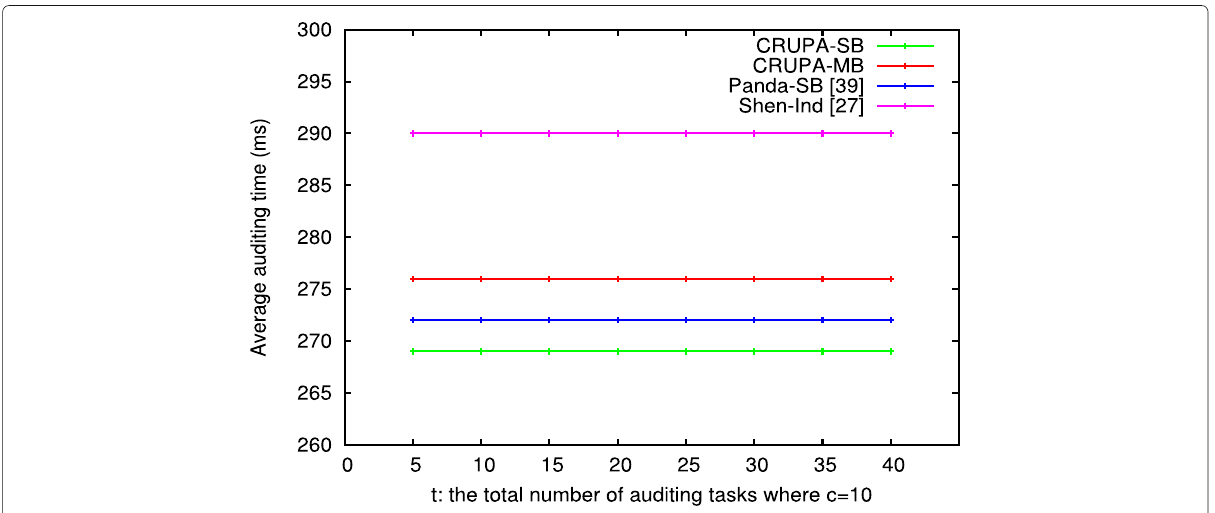
Fig. 6 Impact of t on average auditing time (ms) per task where c=10